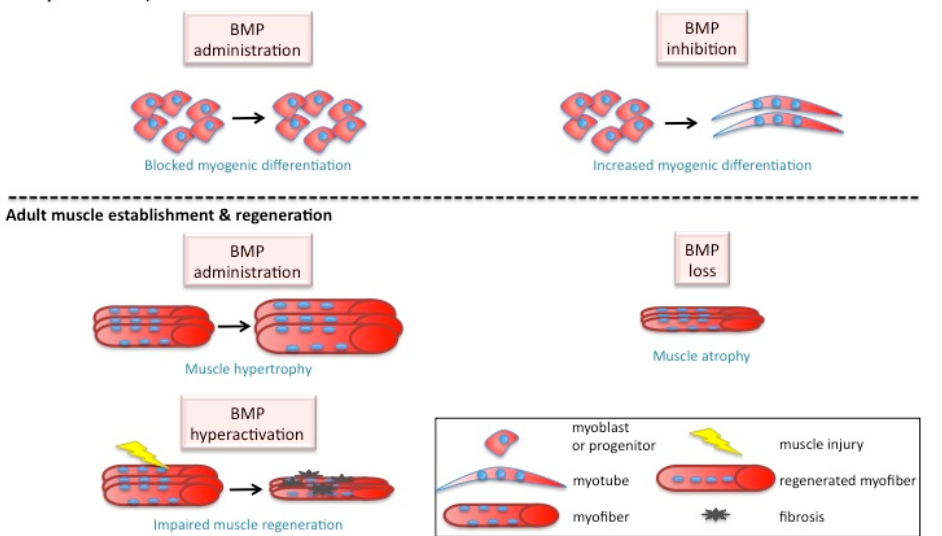
Figure 2. BMP effect on myogenesis. Fine tuning of BMP is essential for normal muscle growth.